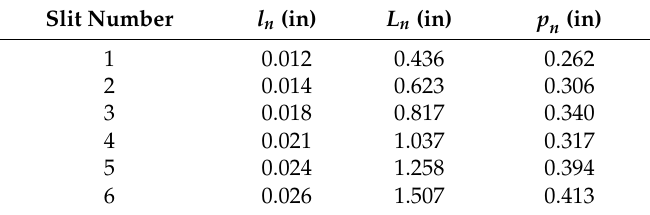
Table 2. Slits’ dimensions on the leading edge of the rib.